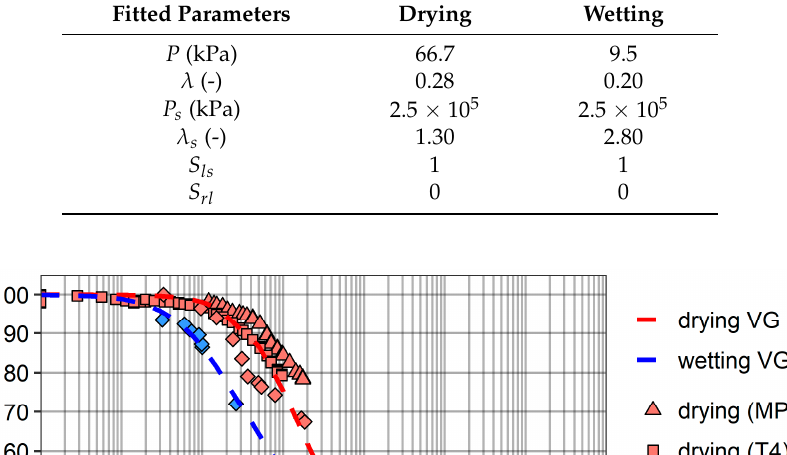
Table 6. Modified van Genuchten soil–water retention curve (SWRC) fitting parameters for drying-wetting paths.